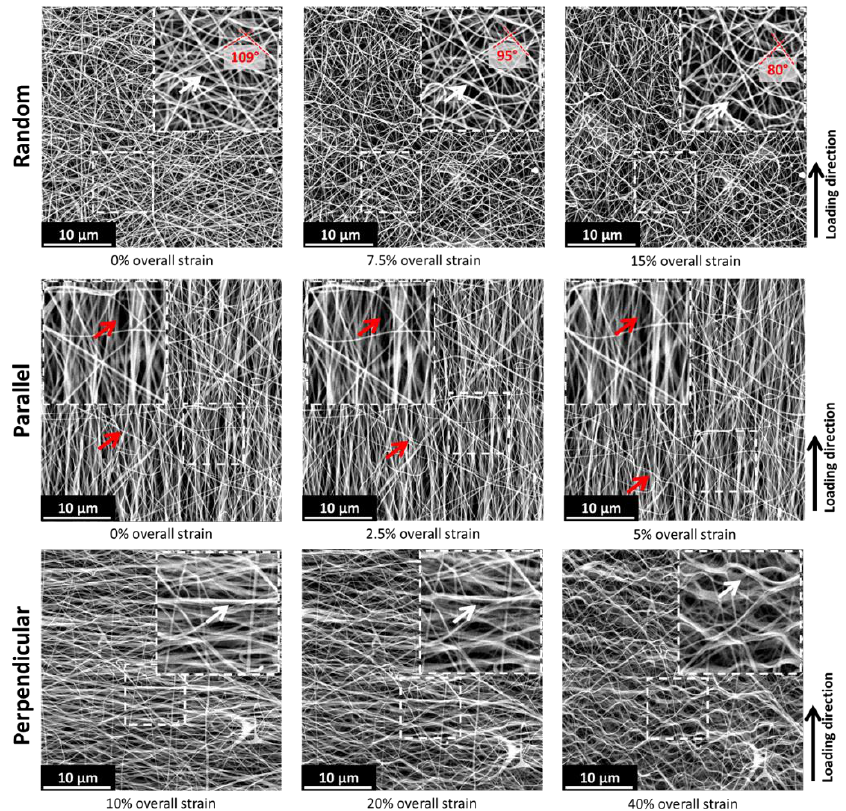
Figure 3. SEM images of nanofiber membranes with different fiber orientations during progressive deformation steps. Arrows indicate buckling (white) and reorientation (red) of the individual fibers.